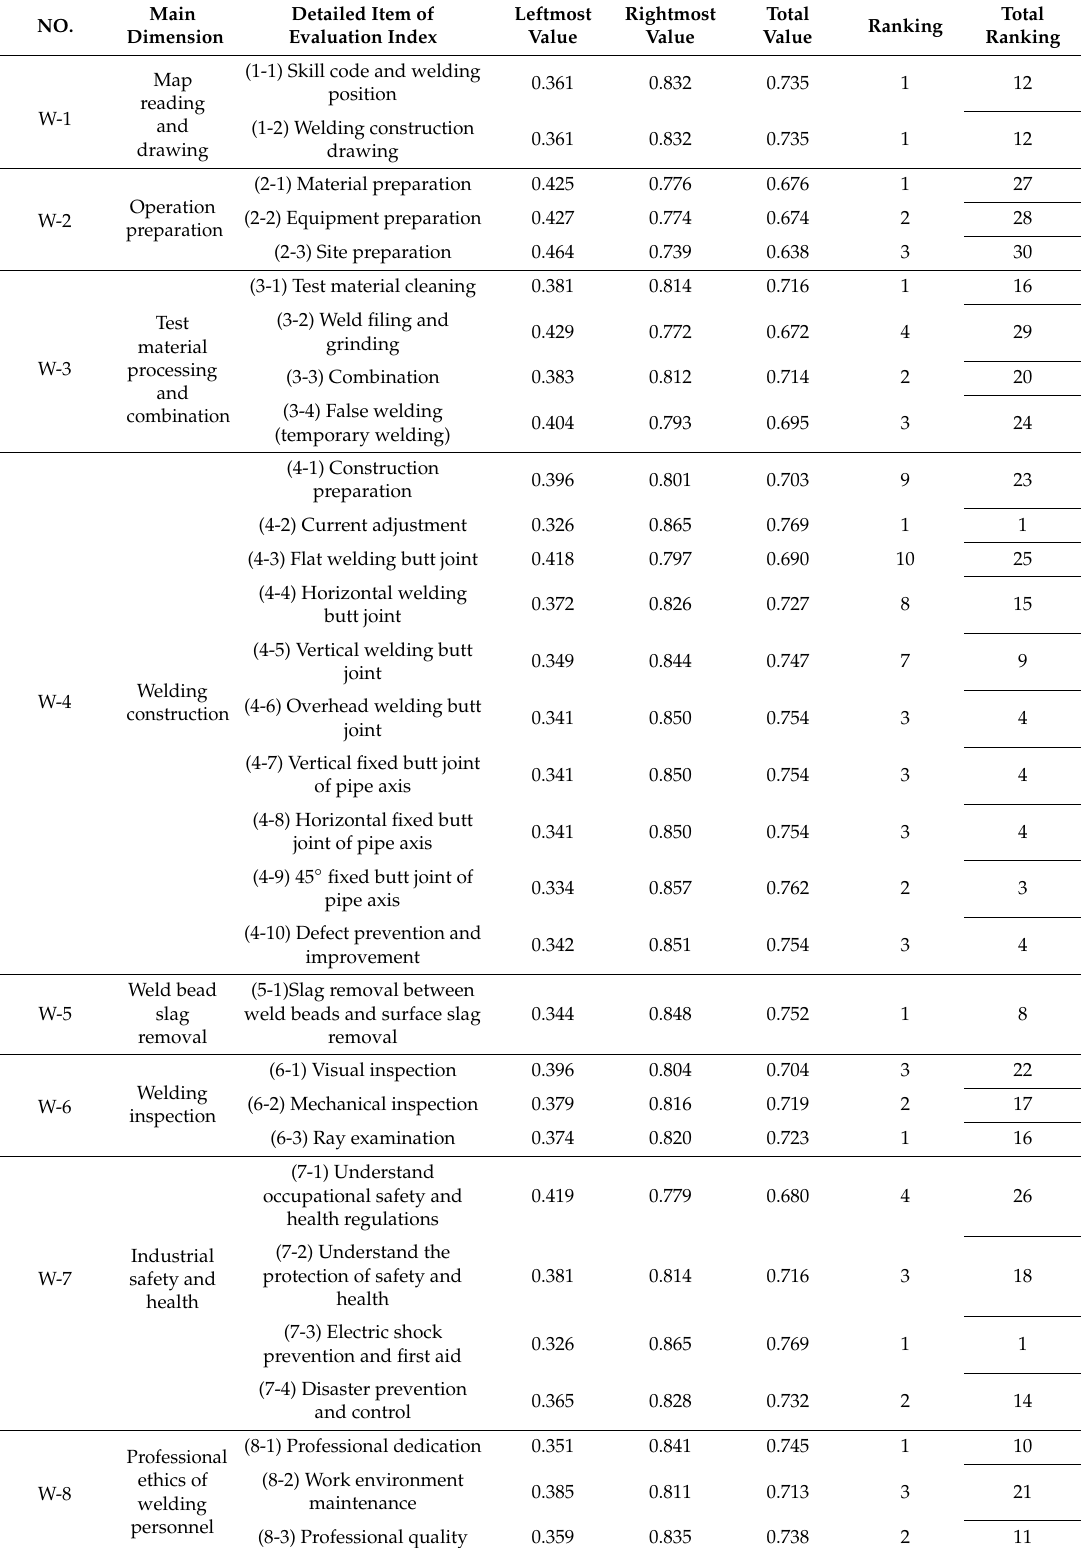
Table 4. Suitability Score Table of 30 Evaluation Indices of the Welding